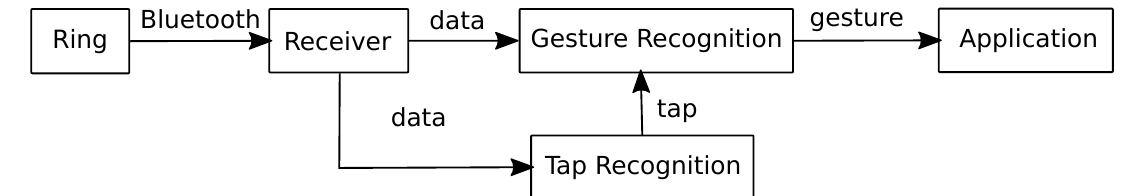
Figure 18. Gesture recognition pipeline for an abstract